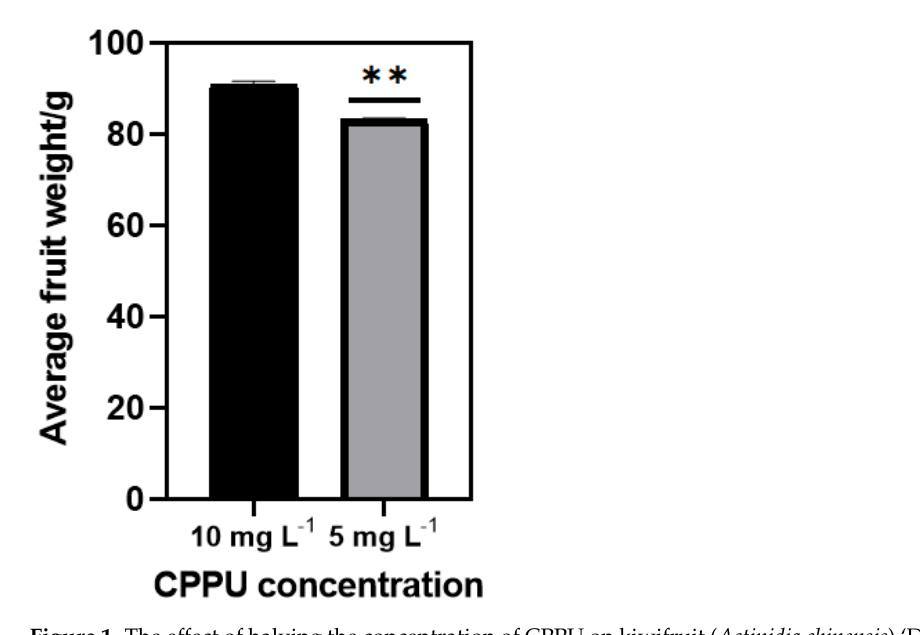
Figure 1. The effect of halving the concentration of CPPU on kiwifruit ( Actinidia chinensis ) ‘Donghong’ enlargement. A ** in the column means that it is significantly different to the control by t-test at p ≤ 0.01. Table 1. The effect of different treatments on fruit quality during kiwifruit ( Actinidia chinensis ) ‘Donghong’ ripening.